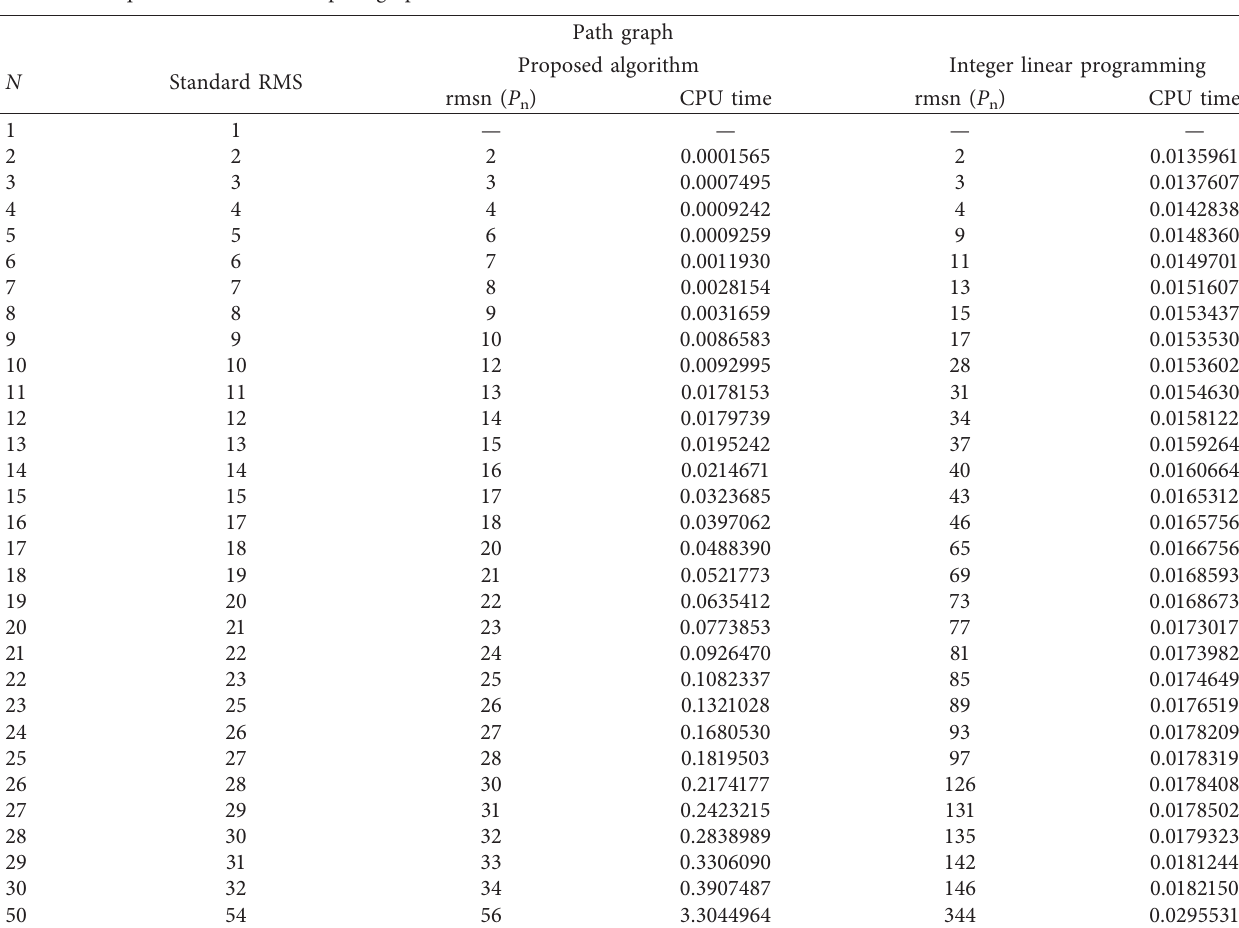
Table 2: Comparison between standard radio mean square number, algorithm, and integer linear programming for the upper bound of radio mean square number for the path